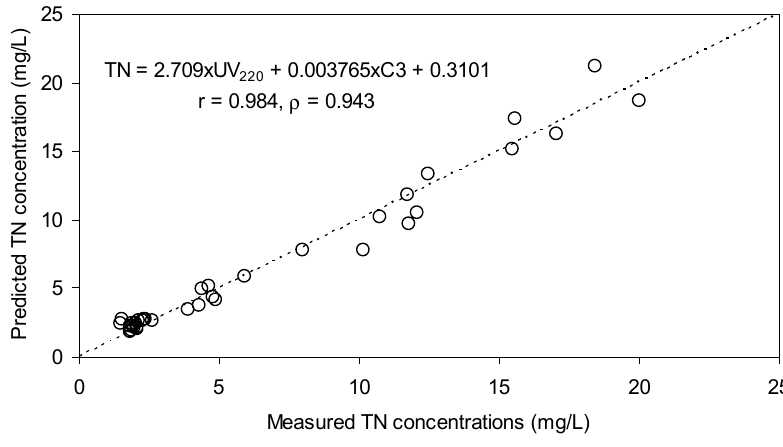
Figure 6. Correlations between the measured TN concentrations and the predicted values by multiple regression